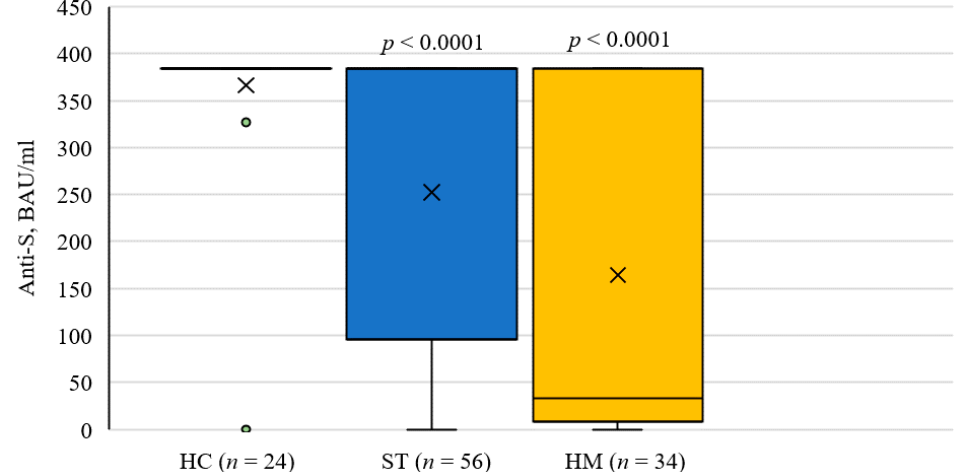
Figure 2. Anti-spike Antibody Concentrations in Healthy Controls and Cancer Patients with Closely Matched Dosing Intervals (Average 60 Days versus 54 Days, Respectively), Following Two Doses of SARS-CoV-2 Vaccine. p -values are determined by Tukey test against healthy controls. HC: healthy controls; ST: solid tumor; HM: hematological malignancy.